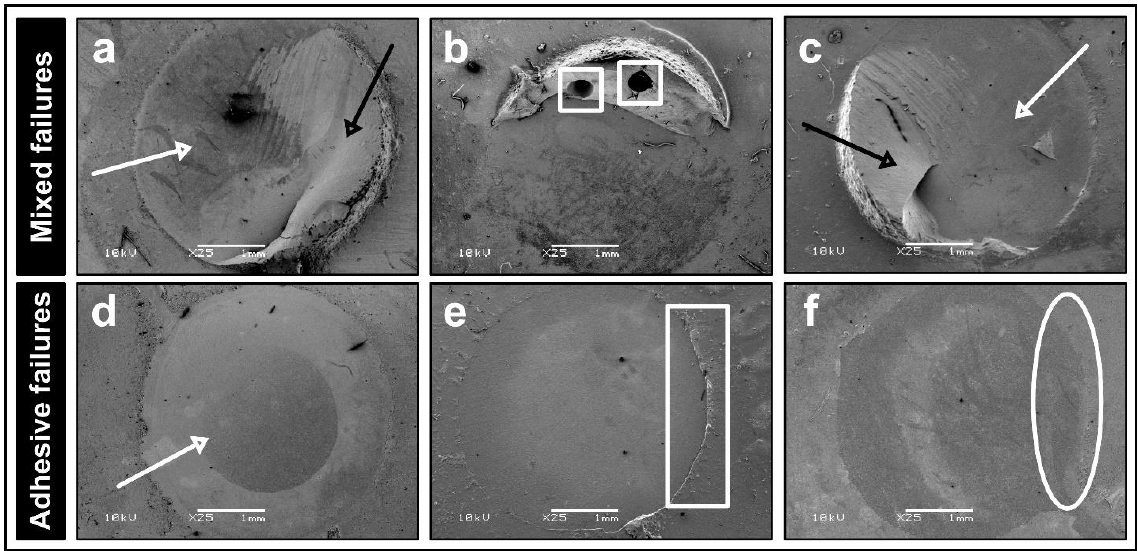
Figure 5. Representative SEM micrographs of mixed ( a – c ) and adhesive ( d – f ) failure modes at ×25 magnification. Mixed failures included adhesive failure at the resin – ceramic interface (white arrow, a , c ) and cohesive failure within the resin cement (black arrow, a , c ). Voids (white square, b ) were noticed within the resin cement. Adhesive failures involved interfacial debond- ing between resin cement and ceramic with no remaining resin cement at the ceramic surface (white arrow, d ). While the remaining zirconia primer can be detected (white rectangle, e ) after 24 h of testing, it was washed away (white ellipse, f ) after